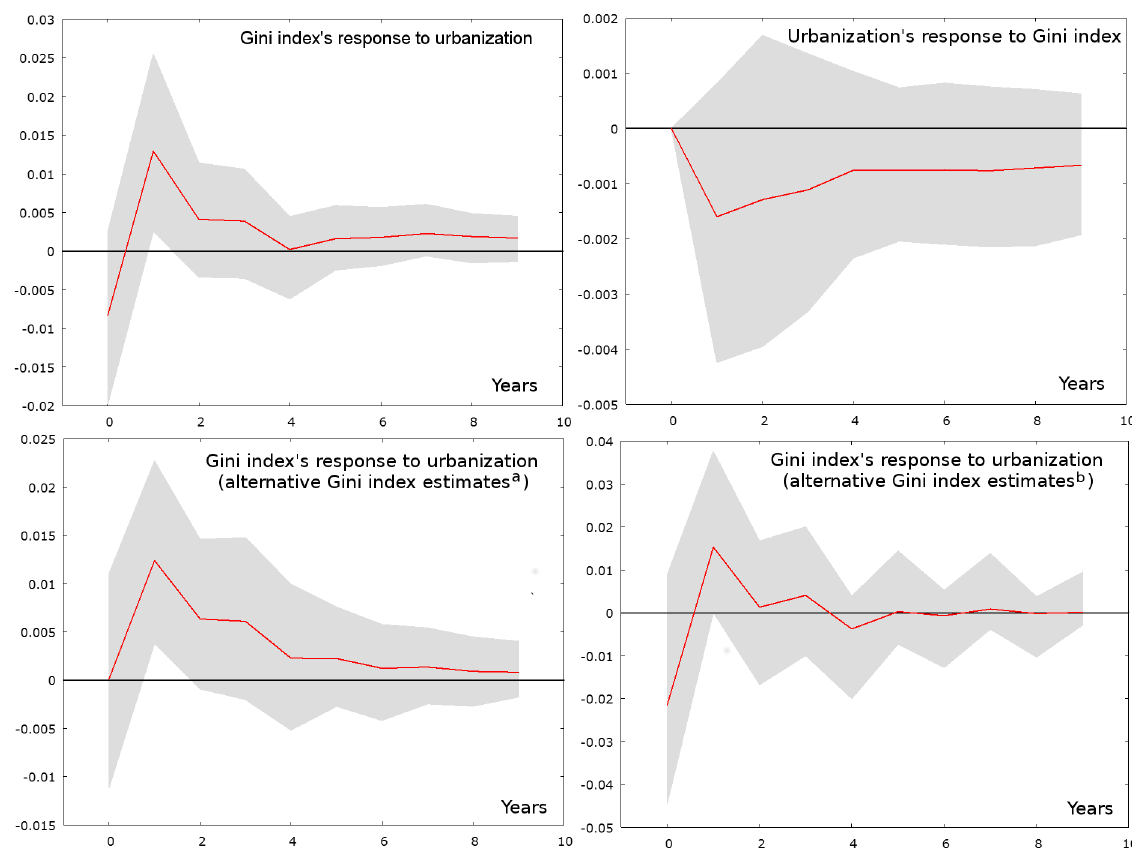
Fig 3. Impulse response functions with 90% intervals. a Using Gini index estimates by Cheng (2010) (Years: 1981 – 2004). b Using Gini index estimates by Wu and Perloff (2006) (Years: 1985 –